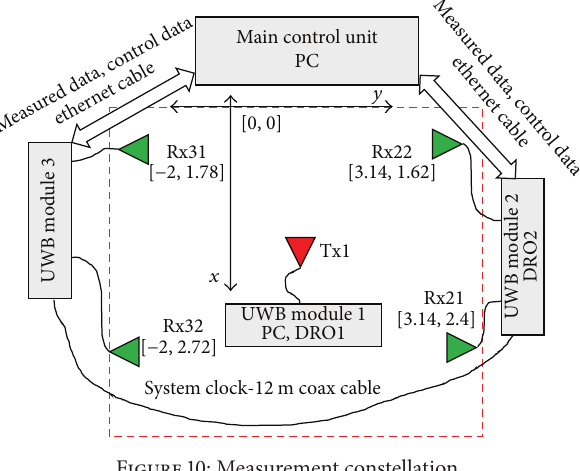
Figure 10: Measurement